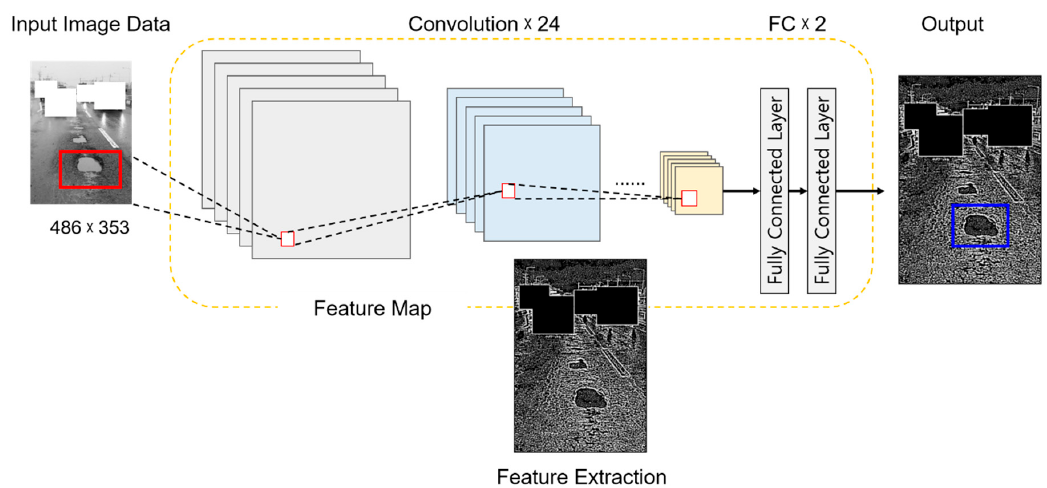
Figure 5. The block diagram of the pothole classification model using edge Detection in road image.